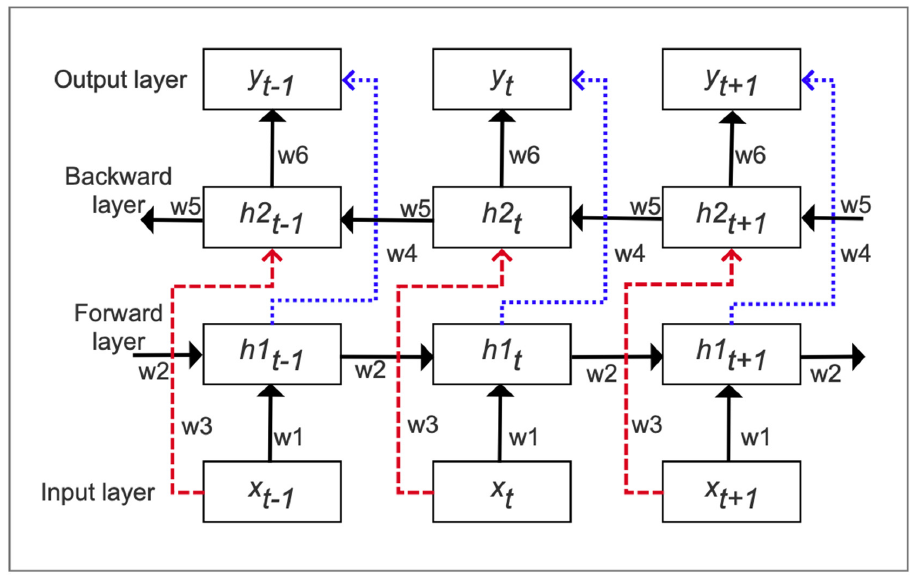
Figure 7. Network structure of Bid-LSTM.